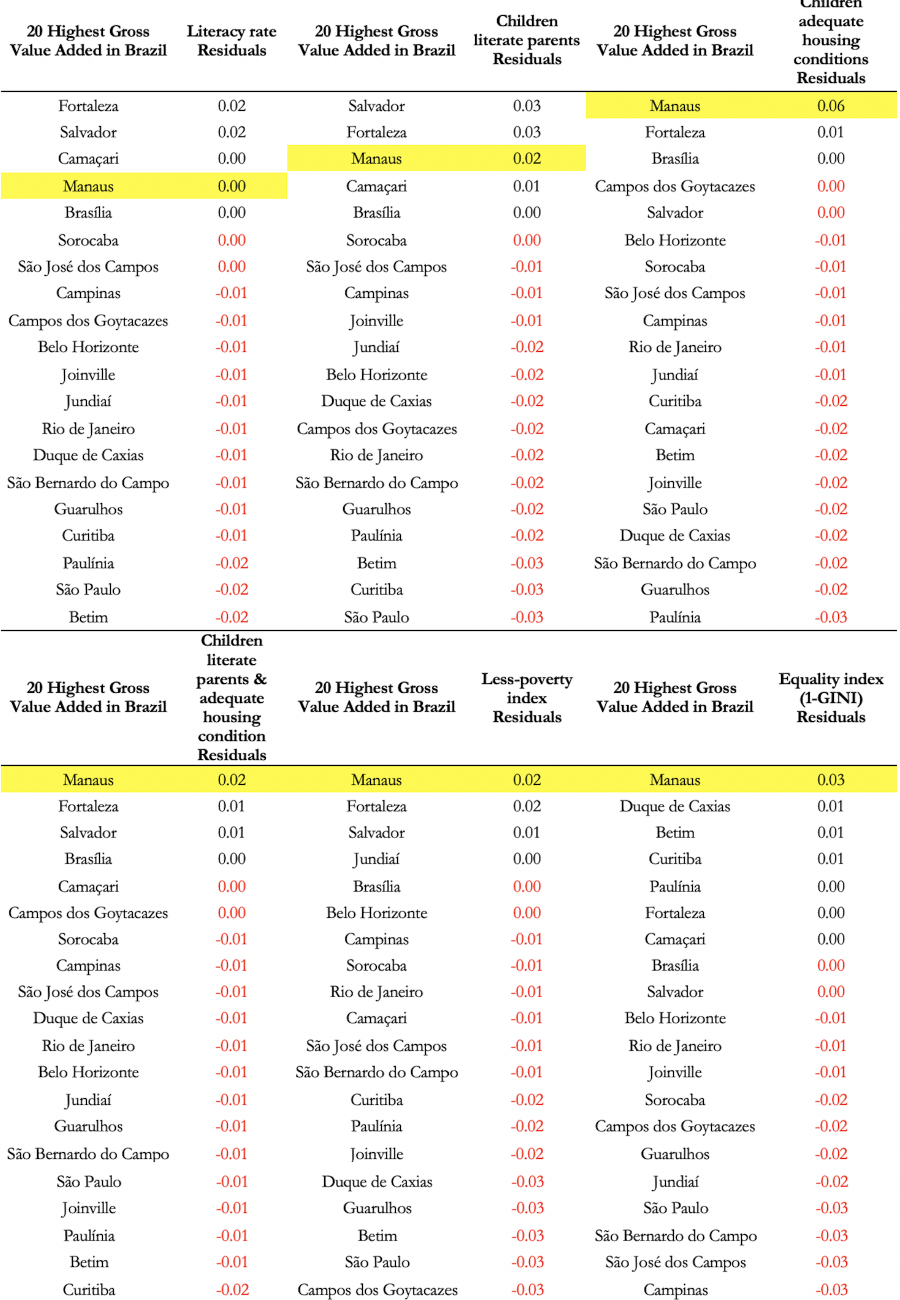
Table 18: Ranking of Social Indicators Residuals (Model A) - per 20 municipalities with the highest industry Gross Value Added in Brazil, per variable